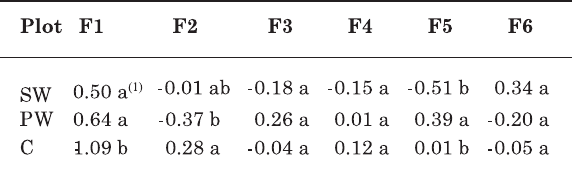
Table 6. Effect of irrigation on factor scores. Plot SW: soil irrigated with sewage wastewater; plot PW: soil irrigated with sodic tap water; plot C: initial soil